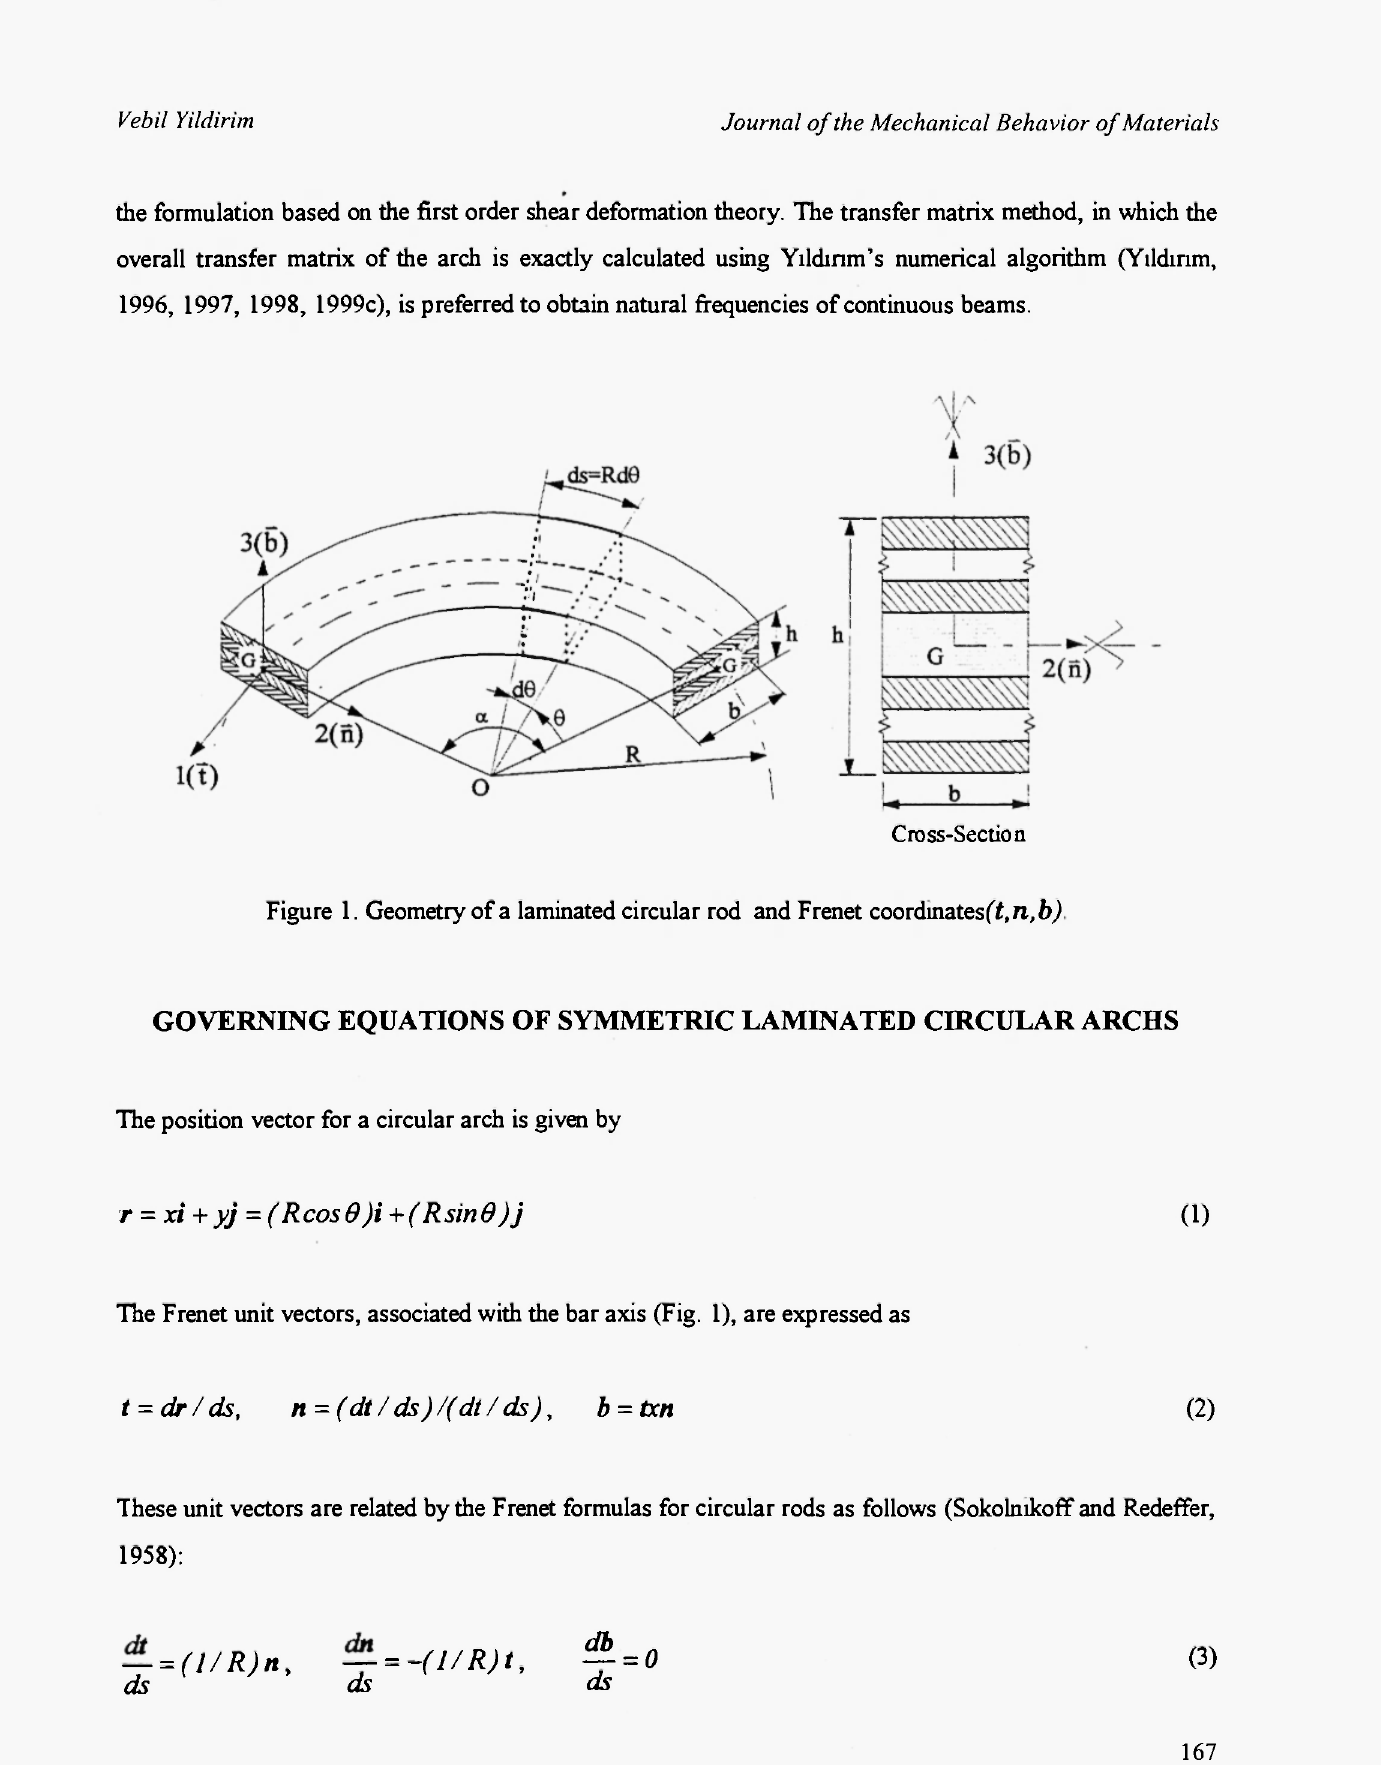
Figure 1. Geometry of a laminated circular rod and Frenet coordinatesf